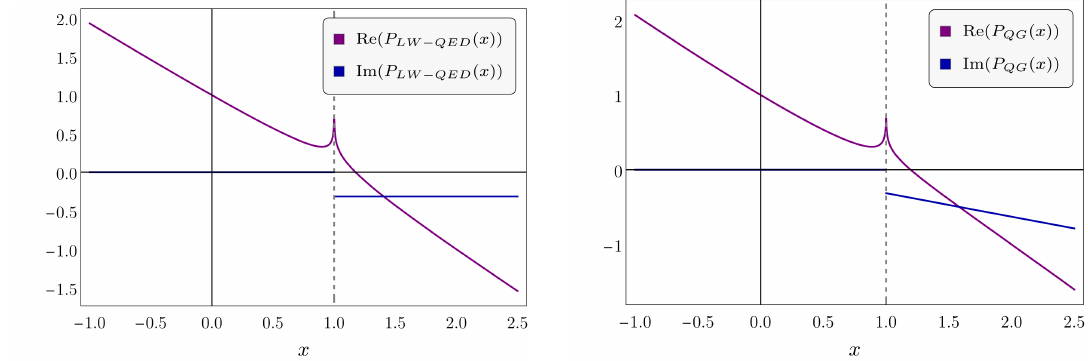
Figure 16 . Real and imaginary parts of the P -functions in eq. (5.3) and eq. (5.4) as functions of x ≡ Re( q 2 ) . The plots are obtained for a = 0 . 1 and b = 1 . Both real parts have a zero in the